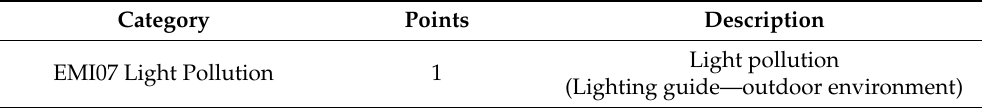
Table 5. Project scorecard EMS College—Emissions category.